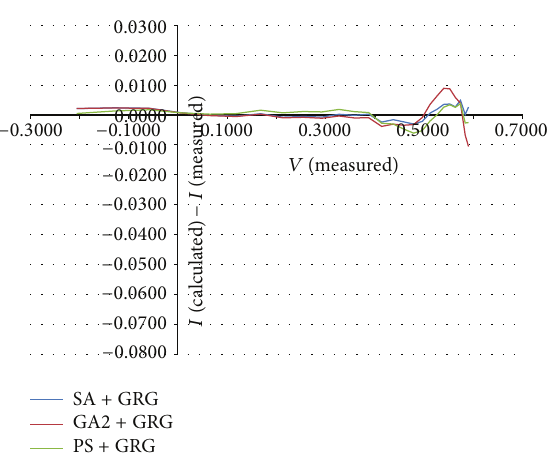
Figure 4: Errors between calculated and measured currents (memetic